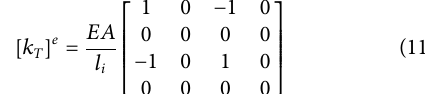
FIGURE 4 Schematic diagram of the calculation of the top beam linear displacement δ u LFkm under a unit